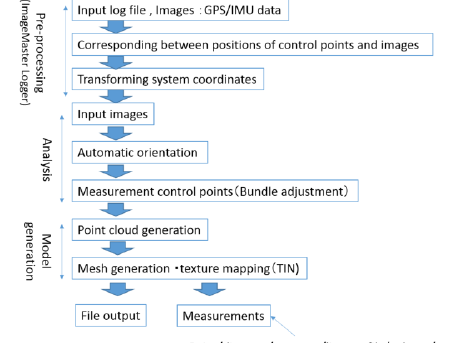
Figure 3. Measuring flowchart of the